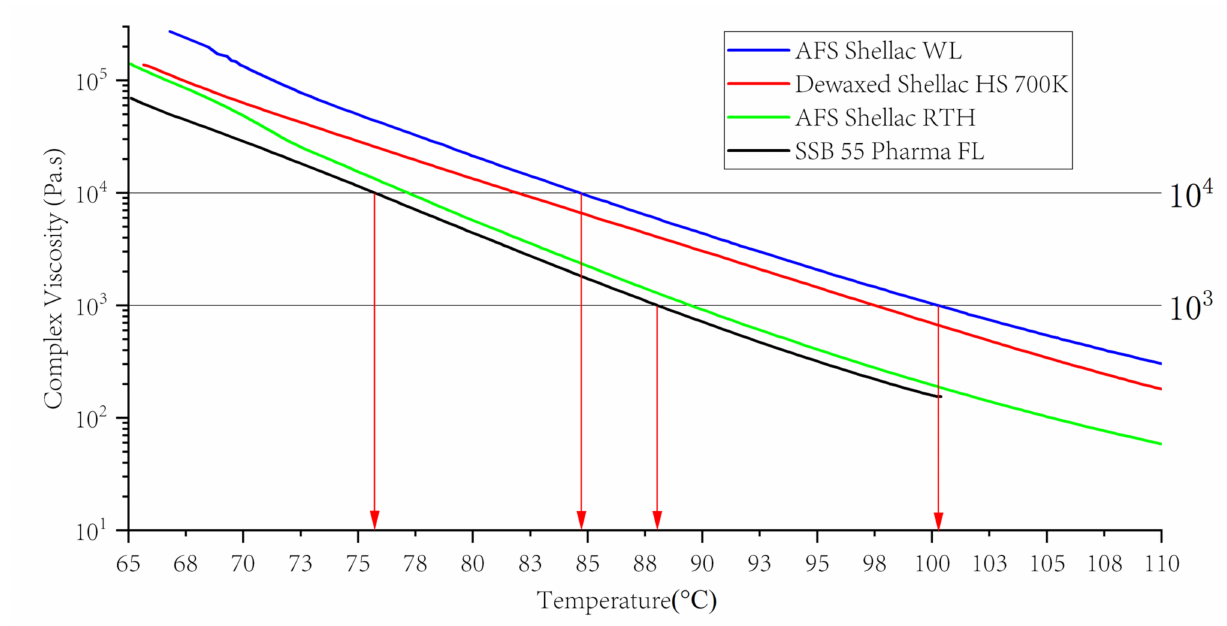
Figure 5. Viscosity versus temperature of various